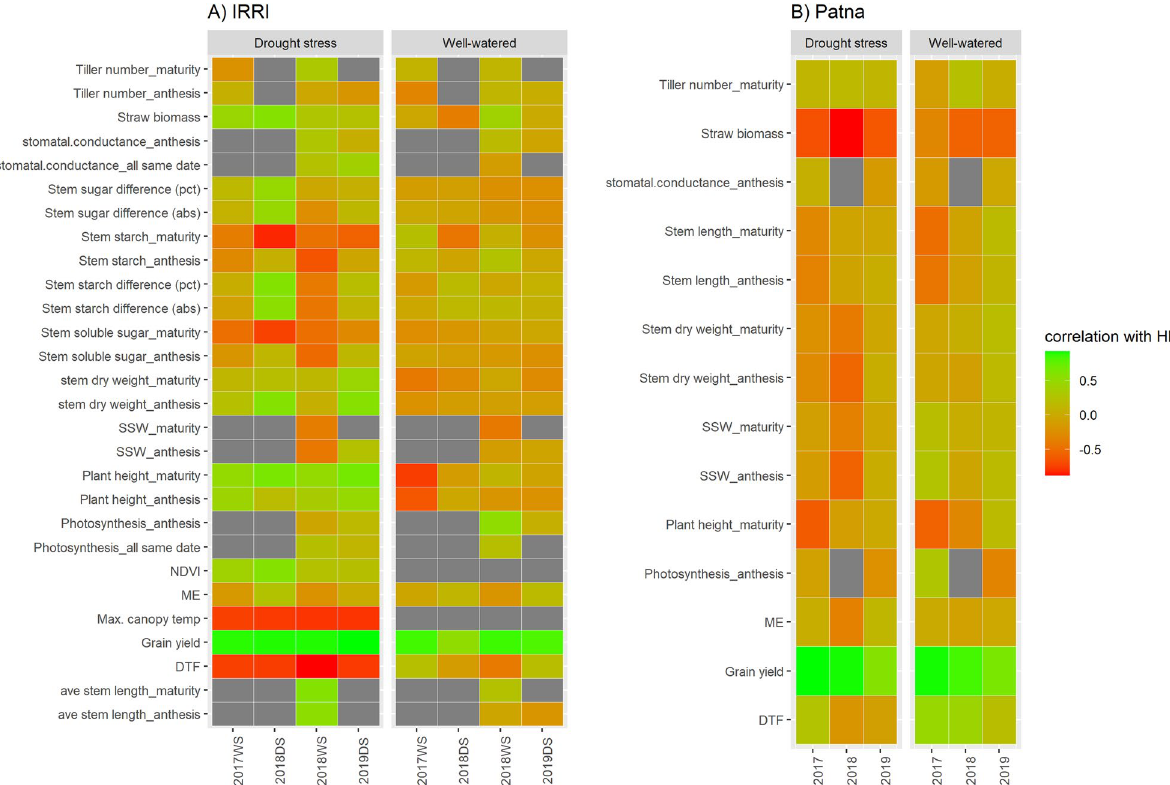
Fig. 4 Correlations between harvest index and the physiological and agronomic traits measured at A IRRI and B Patna. Abs: absolute change, DTF: days to flowering, HI: harvest index, ME: mobilization efficiency, NDVI: normalized difference vegetation index, pct: percent change, SSW: specific stem weight. The year and season of each experiment are shown on the x-axis